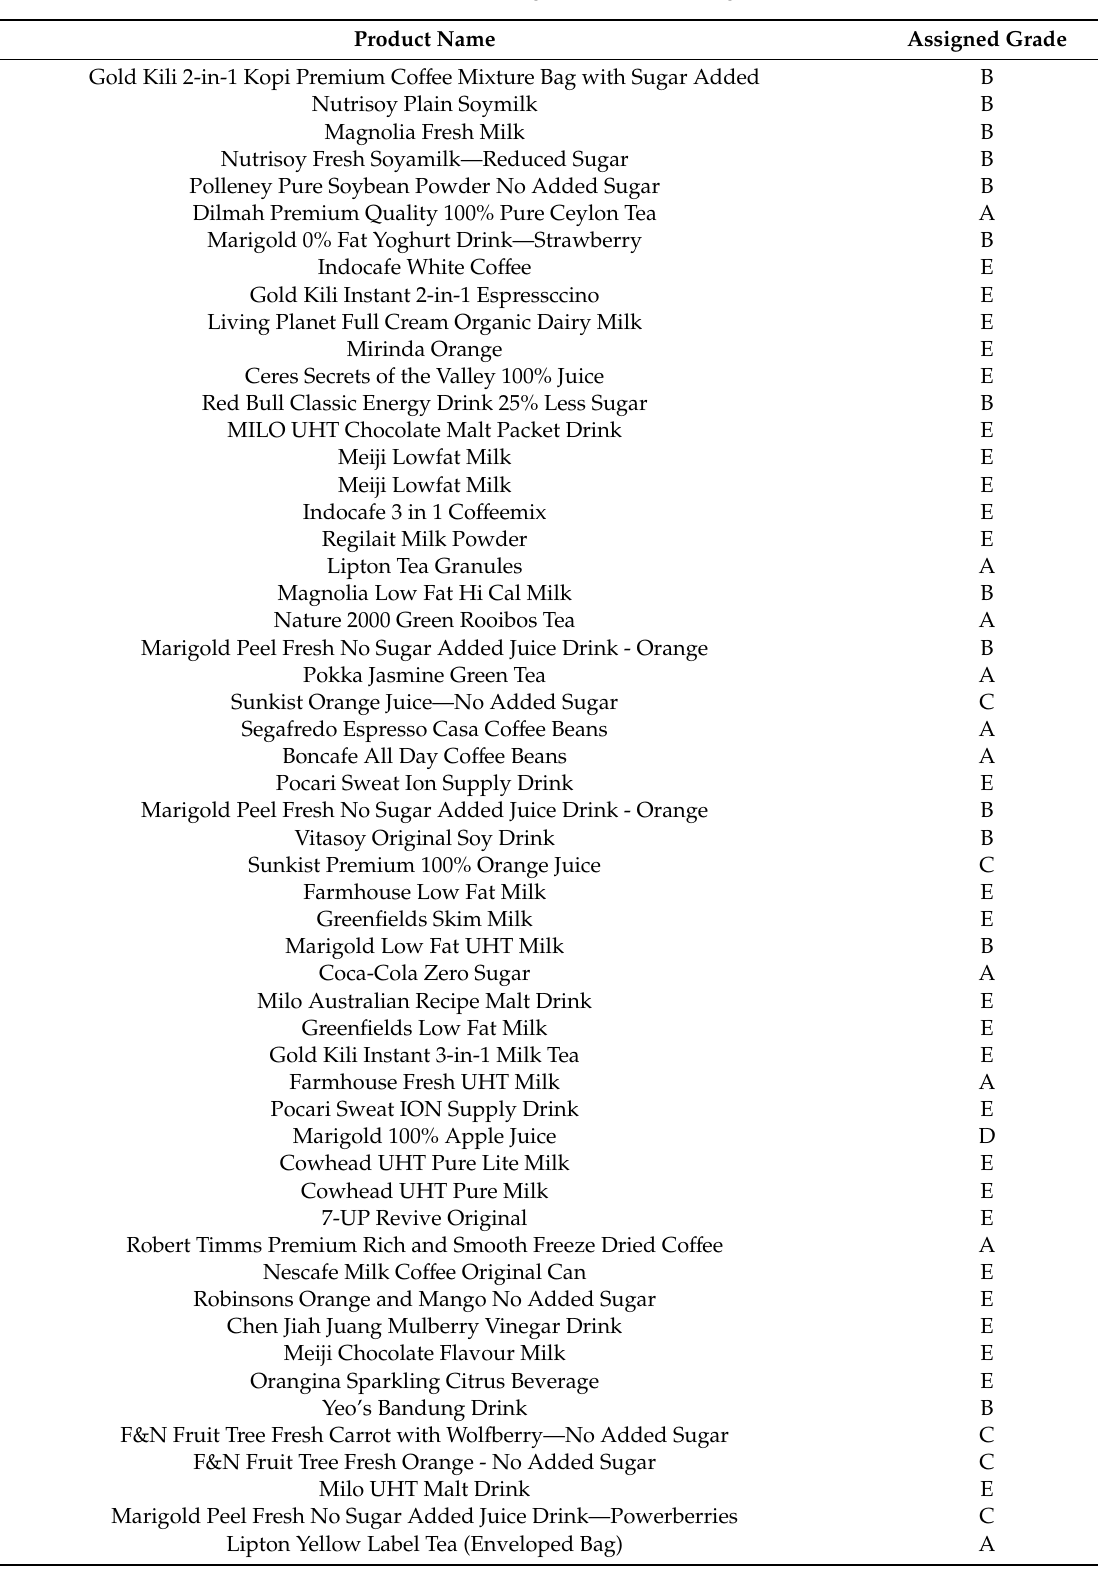
Table A9. Product names and Nutri-Score grades of all beverages sold on NUSMart. Product Name Assigned